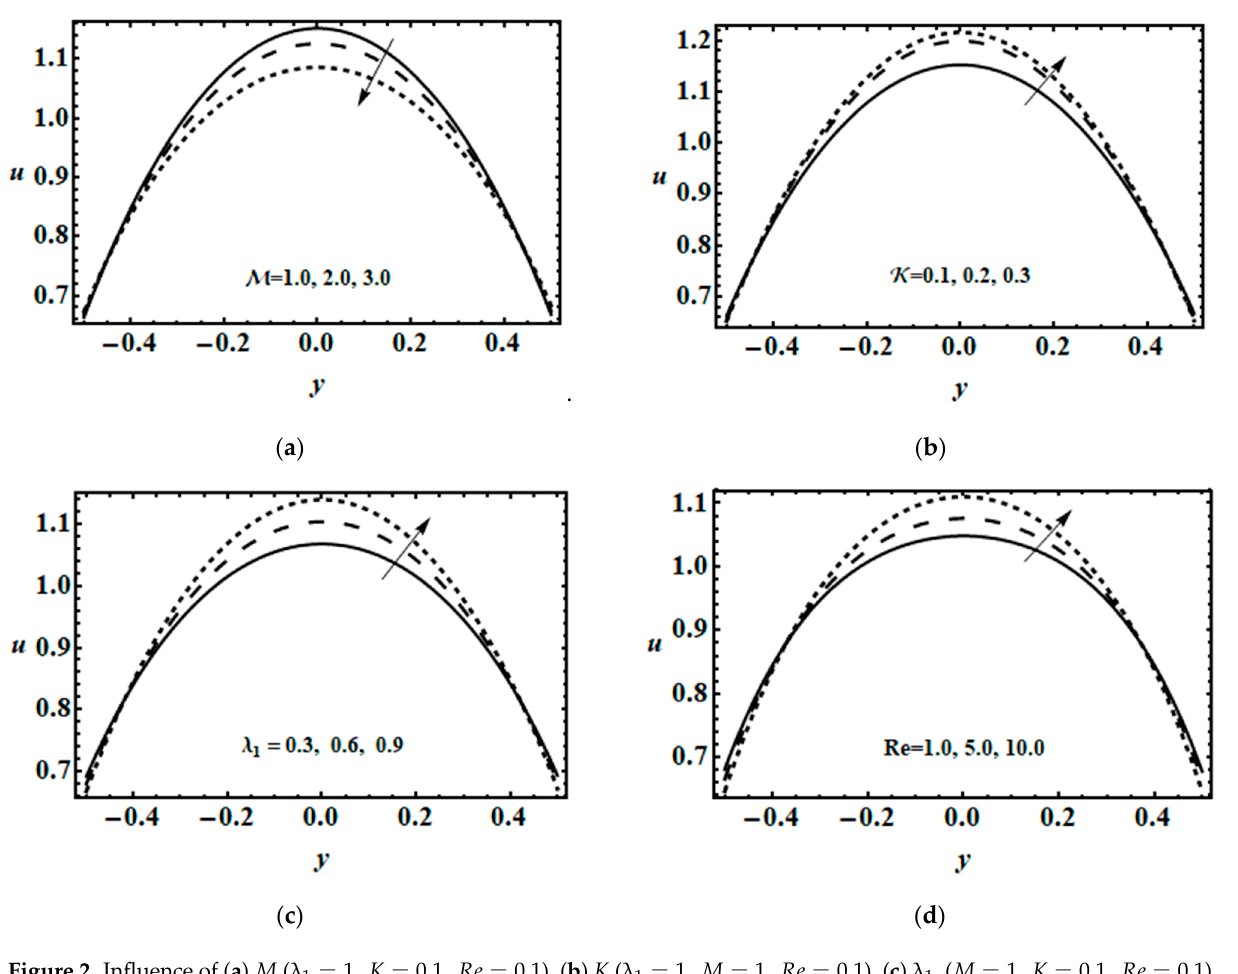
Figure 2. Influence of ( a ) M ( λ 1 = 1, K = 0.1, Re = 0.1), ( b ) K ( λ 1 = 1, M = 1, Re = 0.1), ( c ) λ 1 ( M = 1, K = 0.1, Re = 0.1) and ( d ) Re ( λ 1 = 1, M = 1, K = 0.1) on the horizontal velocity u for α = 0.4, β = 0.4, ε = 0.1, Q = 1.5.